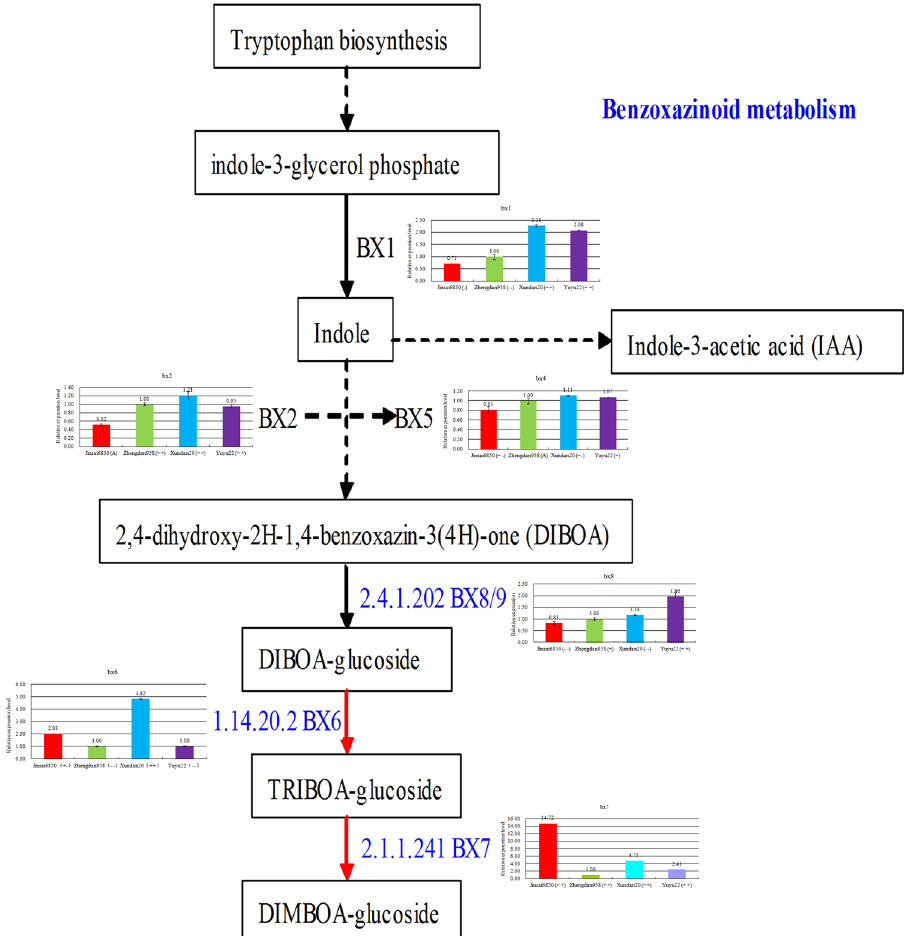
Figure 7. Summary of the benzoxazinoid metabolic pathway as well as the relative expression levels and patterns of key genes in the hybrids. Genes with the associated EC number are provided. Accessions encode the differentially accumulated proteins identified in this study. BX1, benzoxazinless1; BX2 to BX5, cytochrome P450 enzymes; BX8 and BX9, UDP-glucosyltransferases; BX6, dioxygenase; BX7, O-methyltransferase;